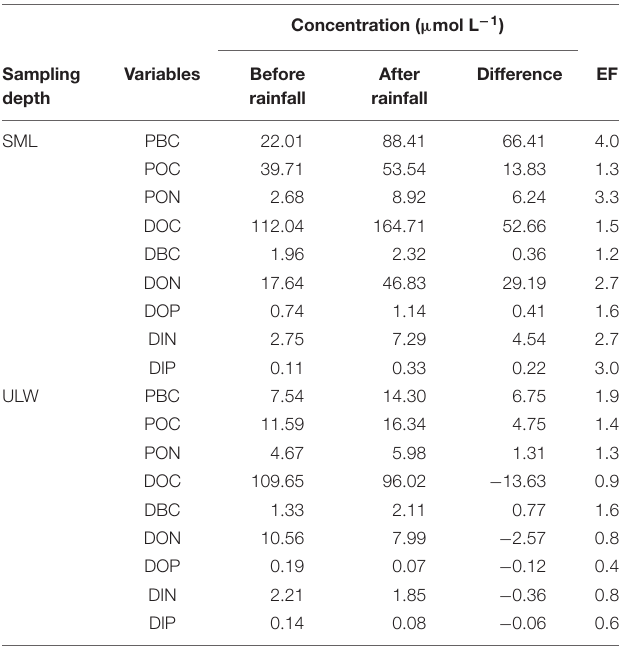
TABLE 1 | Variations of dissolved and particulate inorganic and organic nutrients (DIP, DIN, DOP, DON, PON) and carbon concentrations (DOC, DBC, POC, PBC) in the SML and in ULW during the first rainfall